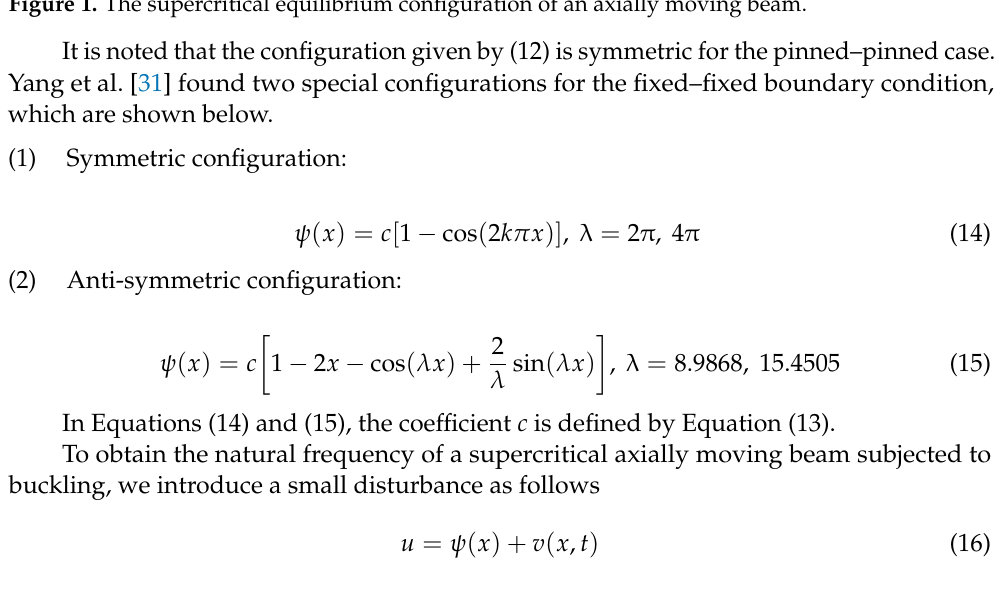
Figure 1. The supercritical equilibrium configuration of an axially moving beam.